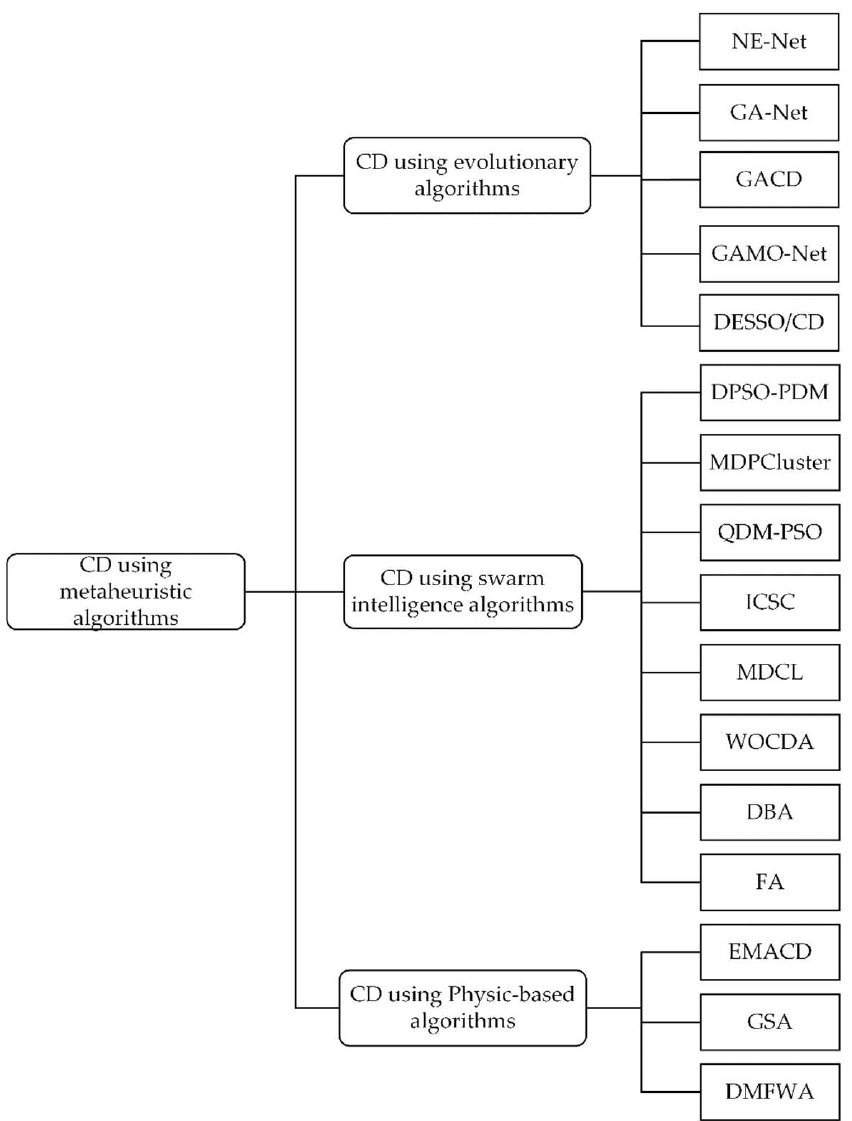
Figure 1. A classification of metaheuristic algorithms used for community detection. Shi et al. [14] proposed GACD, in which a kind of genetic representation is introduced for use in community detection, which is called locus-based adjacency representation (LAR). In addition, the authors used a simple way of crossover and mutation based on their representation. In another work, Moradi et al. [60] proposed an enhanced genetic algorithm for community detection named EGACD by proposing a local search strategy. The proposed strategy is to improve the accuracy and increase the convergence speed up of the GACD algorithm. In EGACD, LAR is used to represent the individuals, and